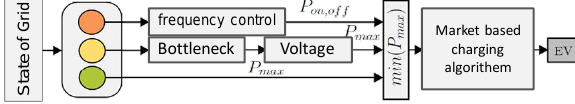
Fig. 8. Concept of grid supporting charging infrastructure